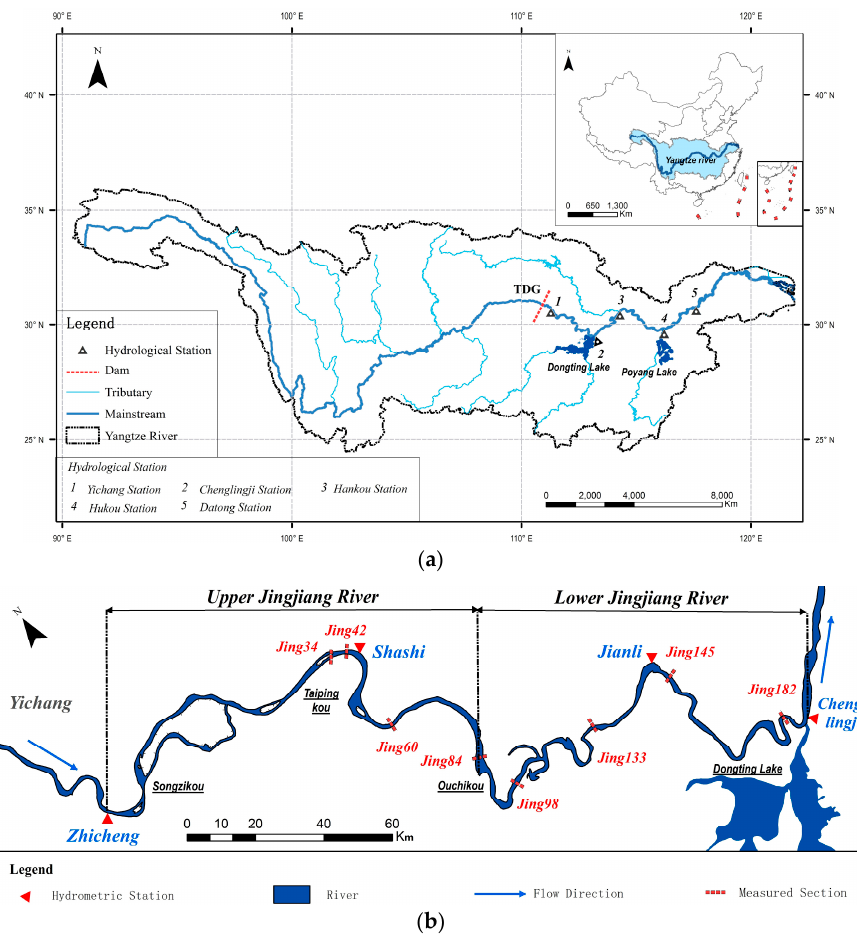
Figure 1. Sketch of the YR ( a ) and JJRR ( b ); ( b ) is drawn from [17].